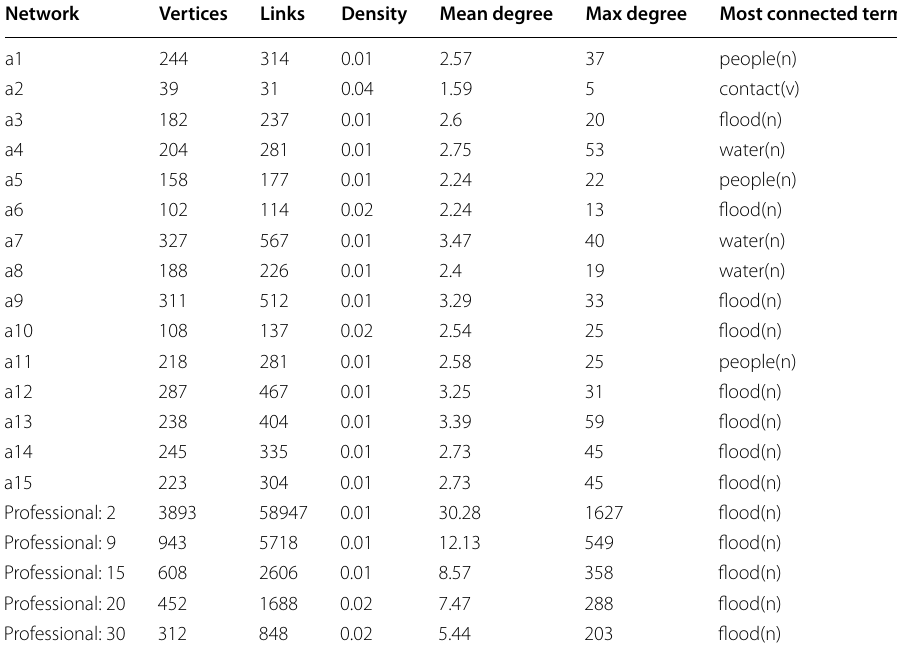
Table 1 Local and professional networks summary statistics